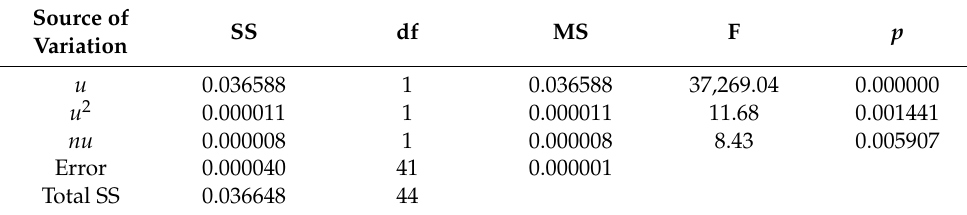
Table 6. Model of density ρ —ANOVA table, R 2 = 0.99; R adj2 =